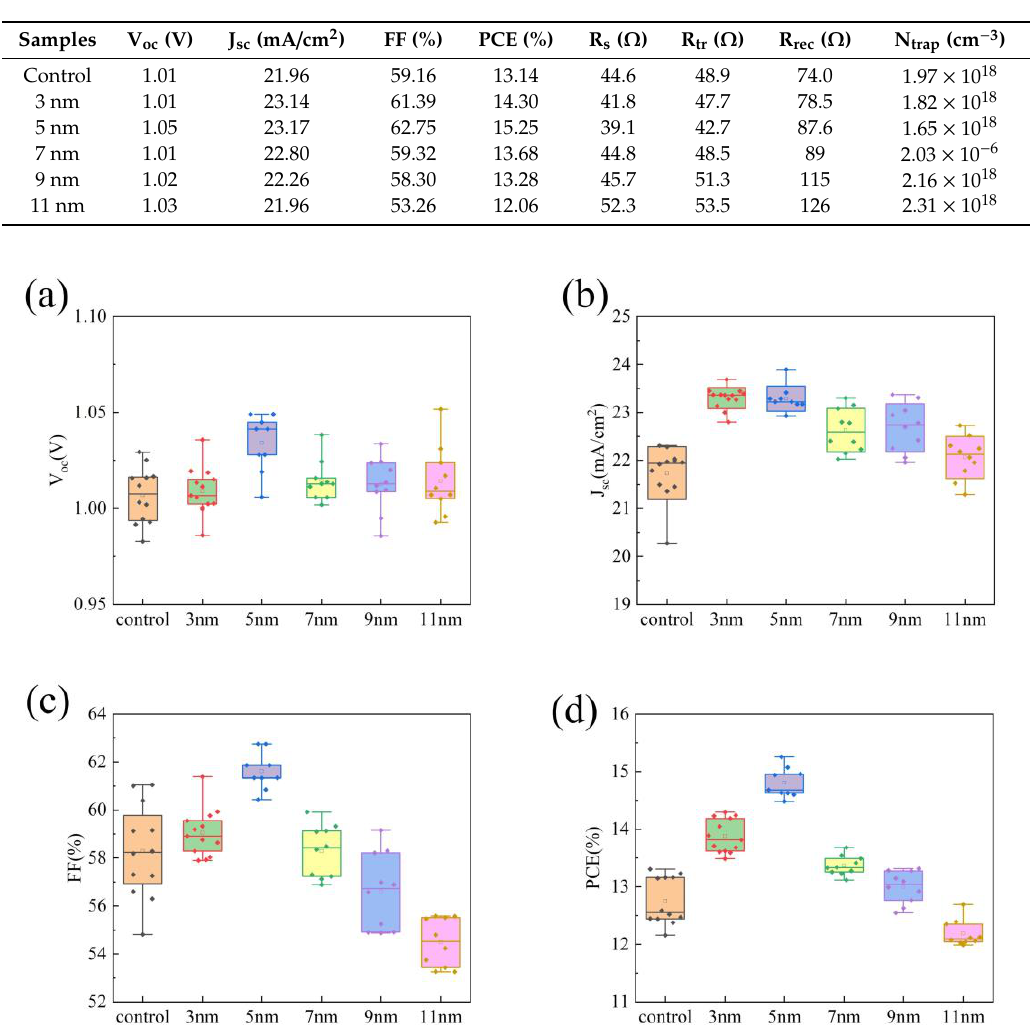
Table 2. Relevant properties parameters of the PSCs with Ag@SiO 2 core-shell nanoparticles (NPs) with a di ff erent shell thickness.